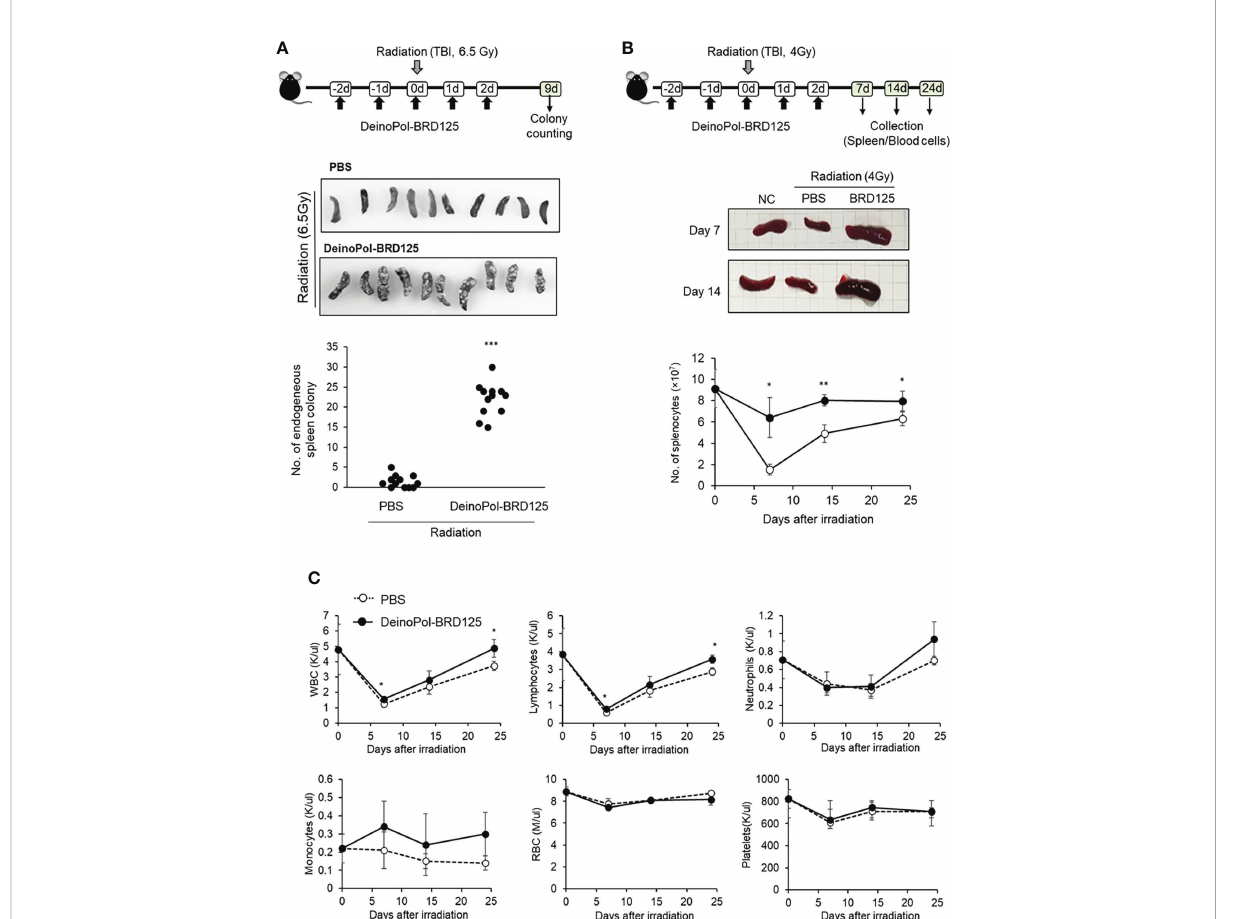
FIGURE 5 Rapid regeneration of hematopoietic stem cells by DeinoPol-BRD125. (A) Mice (n=12) were injected intraperitoneally twice before radiation and an additional third time after radiation with DeinoPol-BRD125 (50 mg/kgBW). Schematic schedule of endogenous spleen colony assay (top). At 9 days after 6.5 Gy radiation exposure, the colonies on the surface of the spleens were visualized (middle) and counted (bottom). (B, C) Mice (n=6) were injected intraperitoneally with DeinoPol-BRD125 (50 m g/BW). Schematic schedule of spleen and blood cell analysis (top). At 7, 14, and 24 days after 4 Gy radiation exposure, the spleens were visualized (middle) and total splenocytes were counted (bottom) (B) . At 7, 14, and 24 days after 4 Gy radiation exposure, the blood were collected in K3EDTA tubes. WBC, lymphocytes, neutrophiles, monocytes, red blood cells, and platelets were analyzed using automatic blood analyzer (C) . *p<0.05, **p<0.01 and ***p<0.001 compared to PBS-injected irradiated